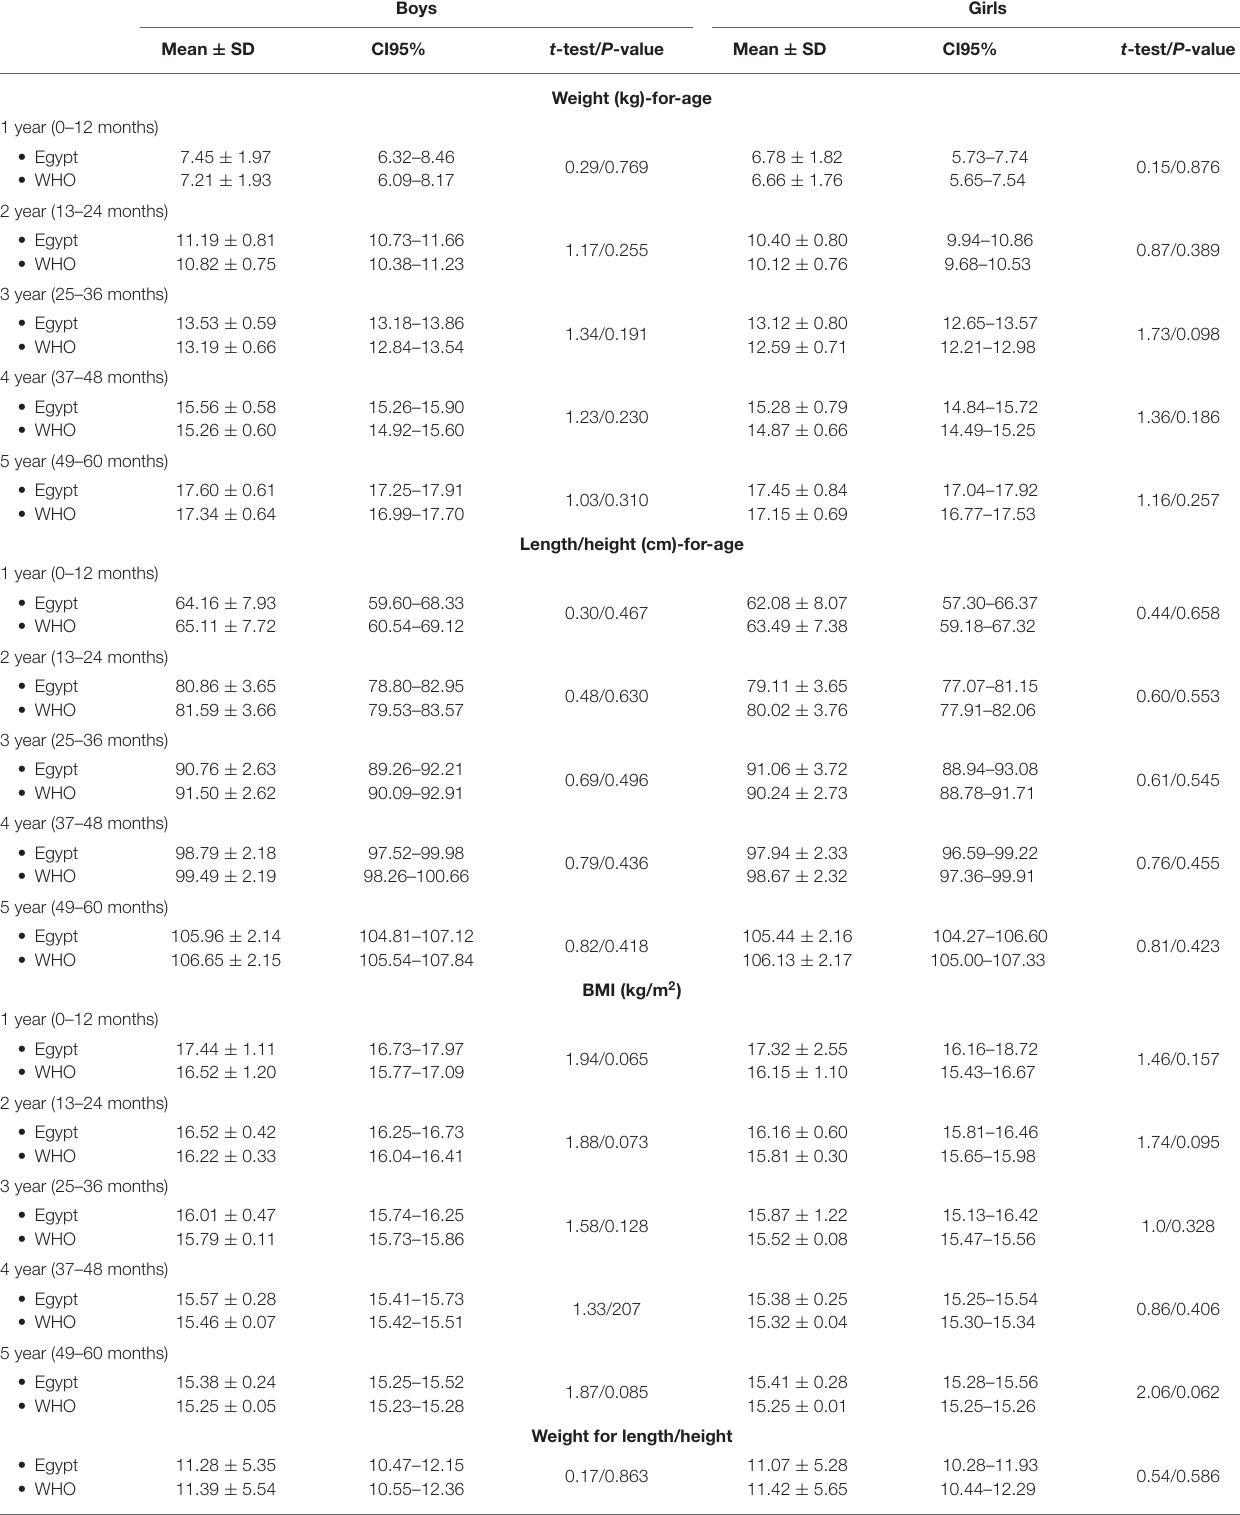
TABLE 4 | Weight for age, length/height for age, BMI for age, and weight for length/height of children from birth up to 5 years relative to WHO growth standards. Boys Girls Mean ± SD CI95% t -test/ P -value Mean ± SD CI95% t -test/ P -value Weight